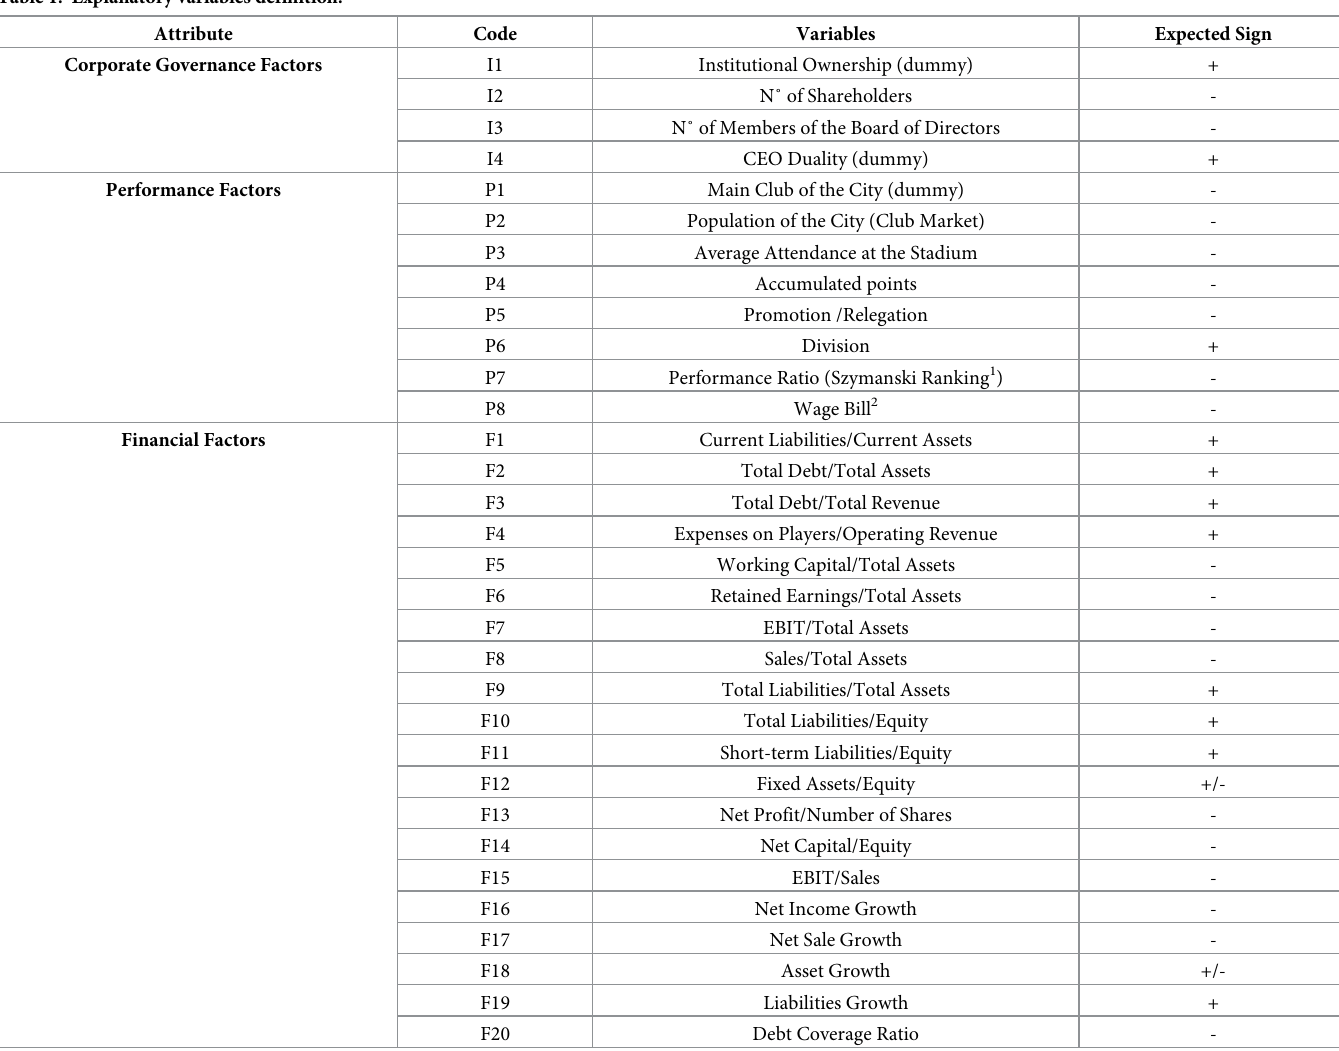
Table 1. Explanatory variables